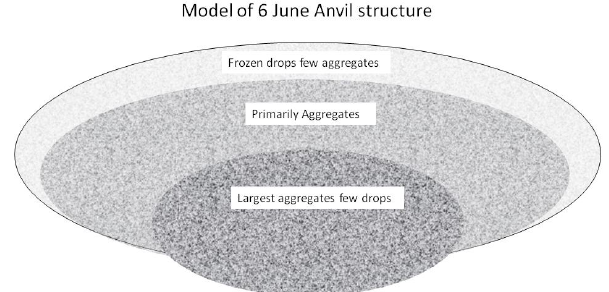
Fig. 12. Depiction of the microphysical structure of the 6 June anvils, based upon the types of ice particles encountered during sampling. The depiction is a vertical cross section perpendicular to the long axis of the anvil. Tops and sides of the anvils were dom- inated by frozen droplets, while the center and lower parts of the anvils had more aggregates and fewer frozen droplets.